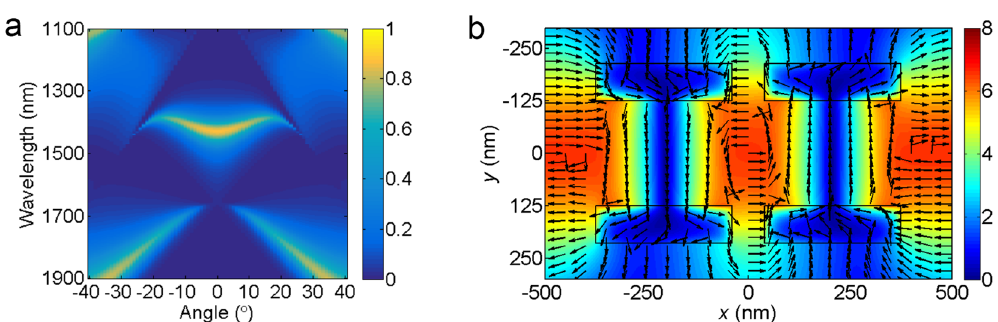
Figure 5. ( a ) Calculated transmission diagrams as a function of incident angle and wavelength in the dual-slit structure. ( b ) Calculated magnetic field intensity | H z | (color map) and electric displacement (arrow map) at the transmittance peak 1454 nm for the dual-slit